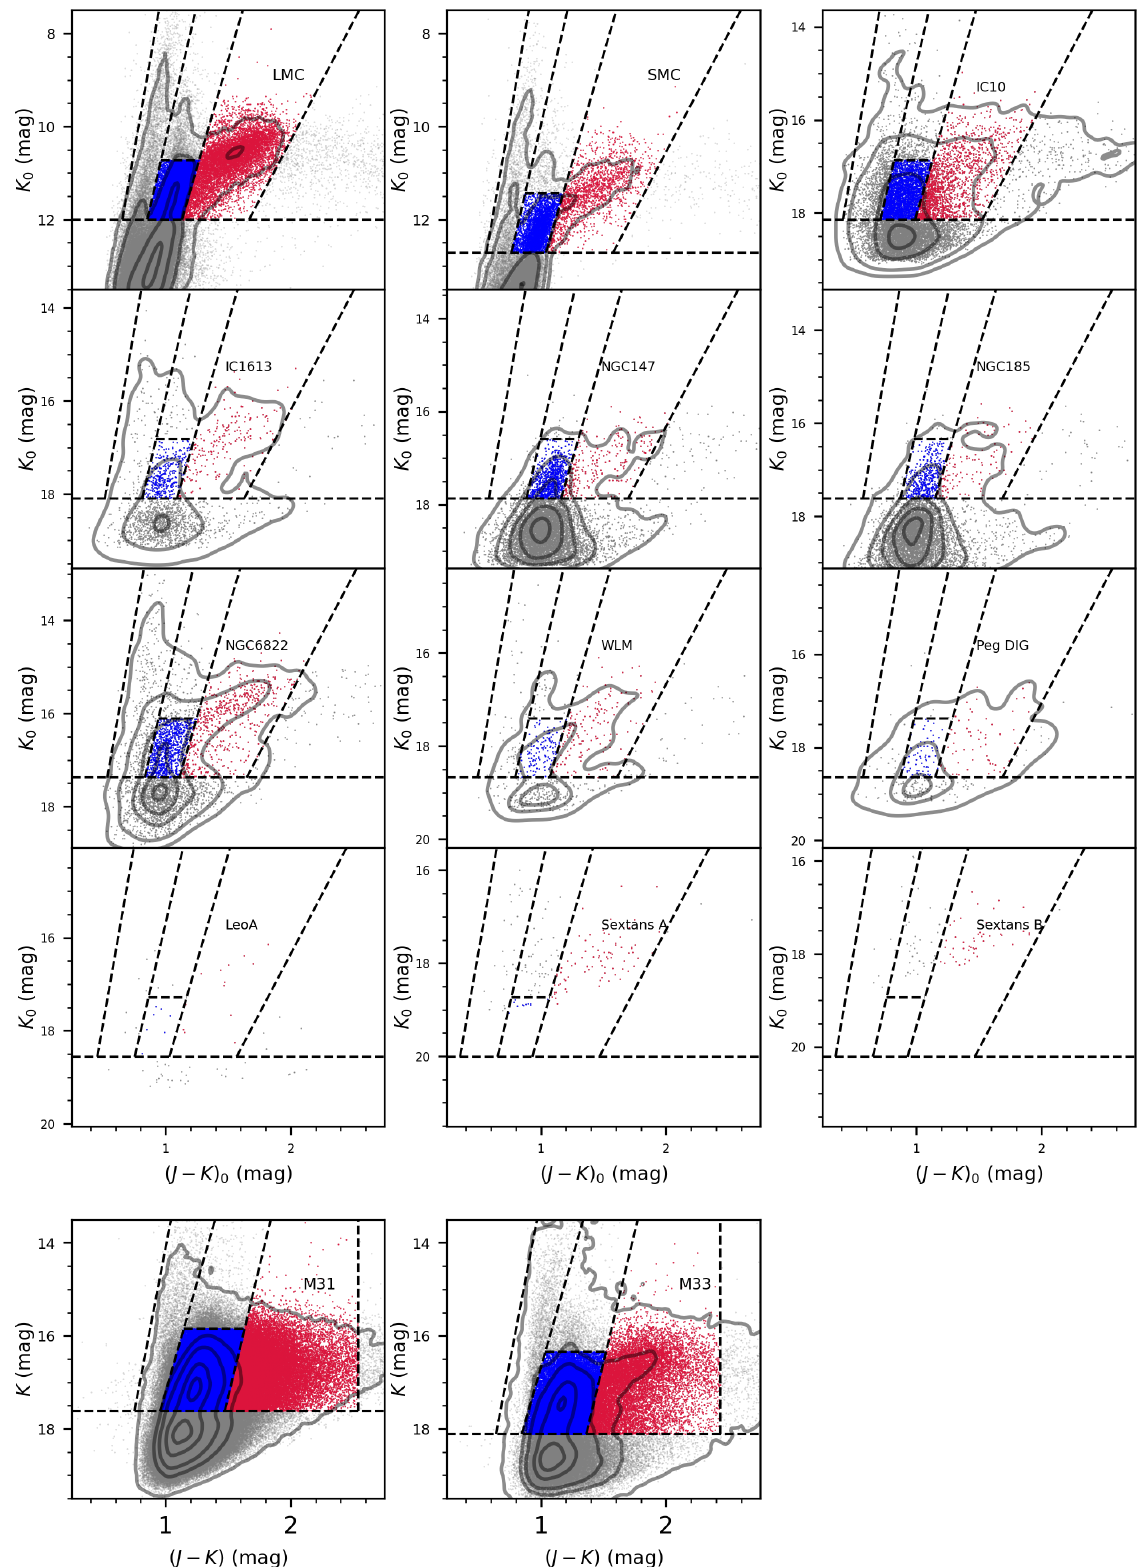
Figure 2. The classification by shifting the boundary lines of the LMC and M33, the benchmark galaxies, to each galaxy according to their positions of TRGB. The C-AGBs and O-AGs are repre- sented by red and blue dots, respectively. Note that 12 galaxies, except M31 and M33, have been extinction